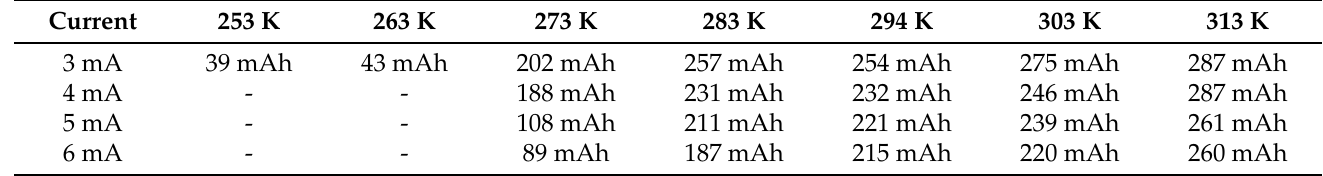
Table 1. Measured capacities depending on discharge current and ambient